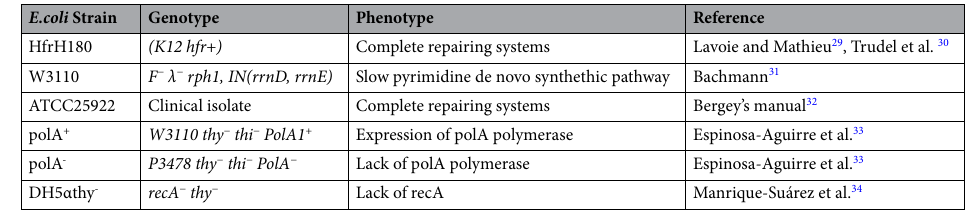
Table 1. E. Coli strains with